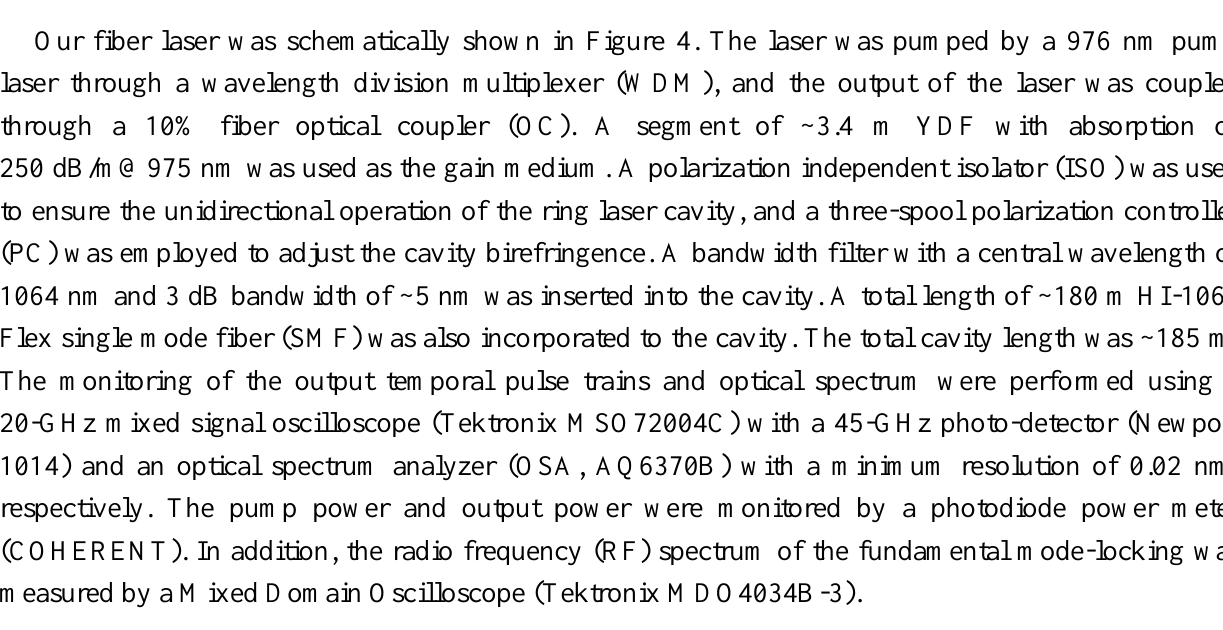
Figure 4. Schematic diagram of the fiber ring